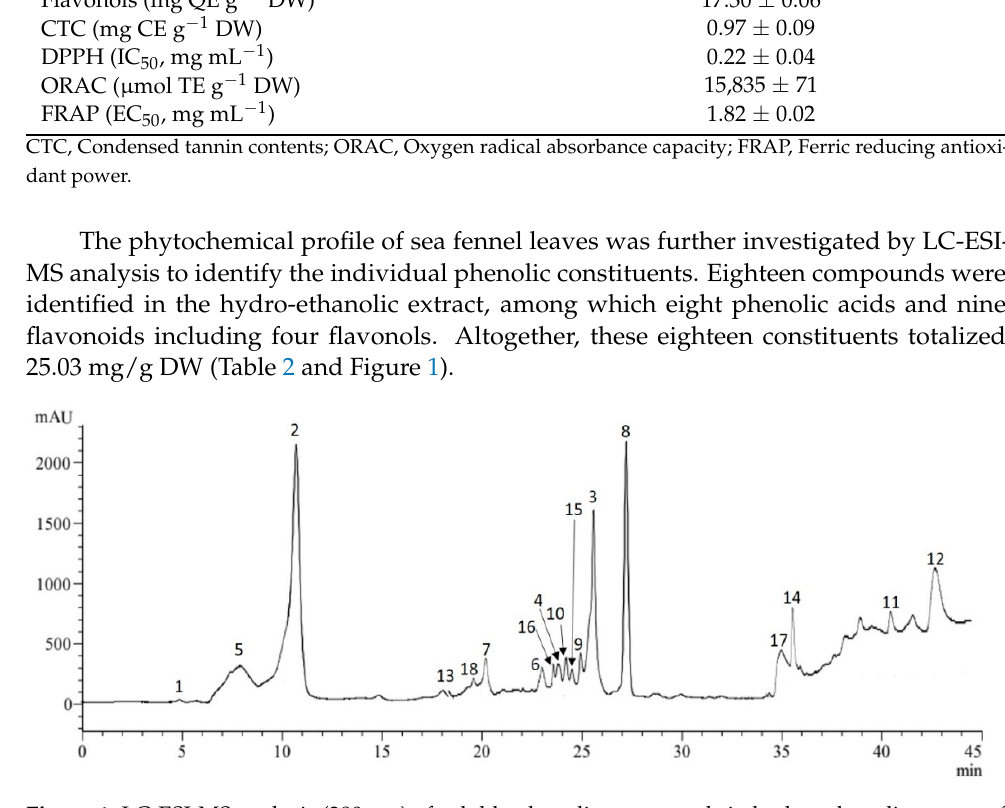
Figure 1. LC-ESI-MS analysis (280 nm) of soluble phenolic compounds in hydro-ethanolic extract of C. maritimum leaves. Peak numbers refer to the standard compounds mentioned in Table 2. Table 2. Content of phenolic acids, flavonoids and flavonols (mg g − 1 DW) identified in the hydro- ethanolic extract of C. maritimum leaves by LC-ESI-MS.